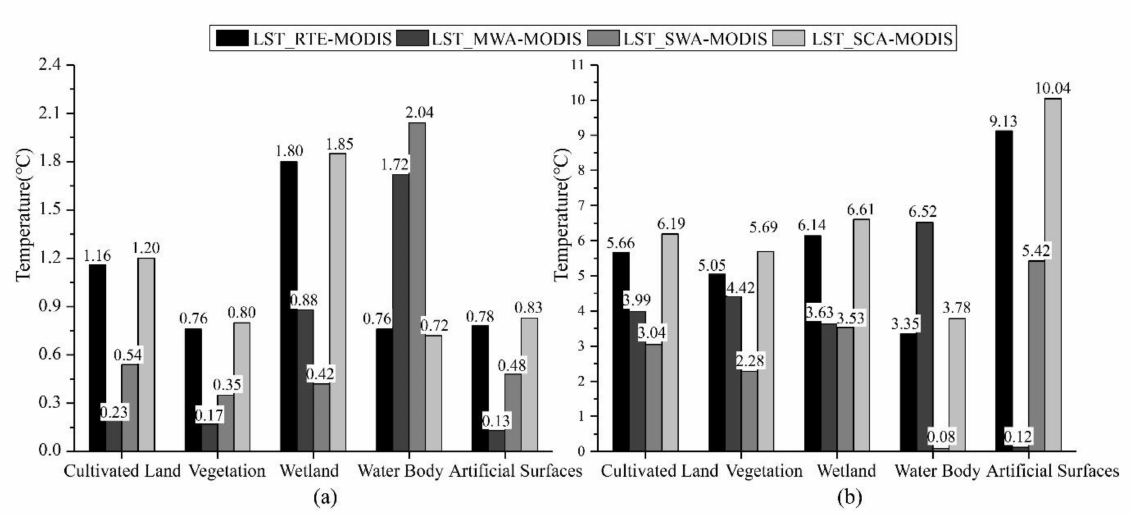
Figure 8. The average temperature difference between the retrieval results of four algorithms and the MOD11A2 surface temperature product under different land cover types. ( a ) are the statistics results of the average temperature difference on 21 January 2020; ( b ) are the statistics results of the average temperature difference on 16 August